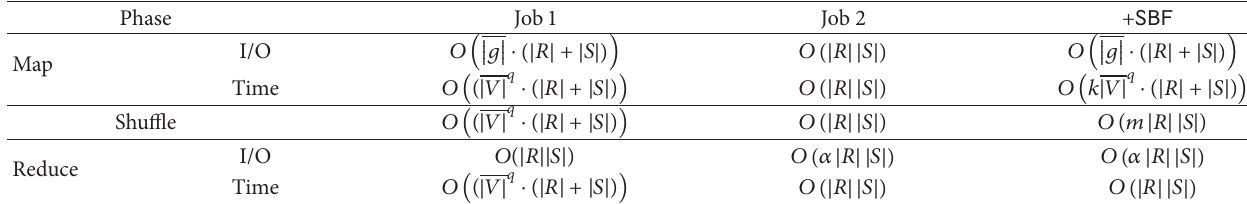
Table 1: Complexity analysis of